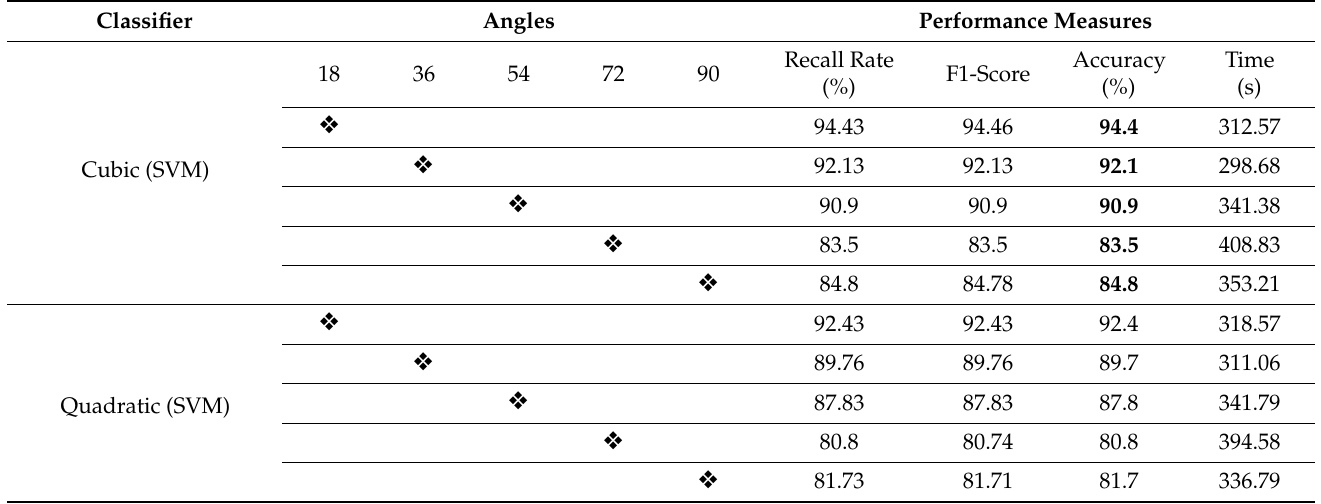
Table 3. Gait recognition results using modified NasNet-Mobile on selected angles of the non-augmented CASIA B da- taset.